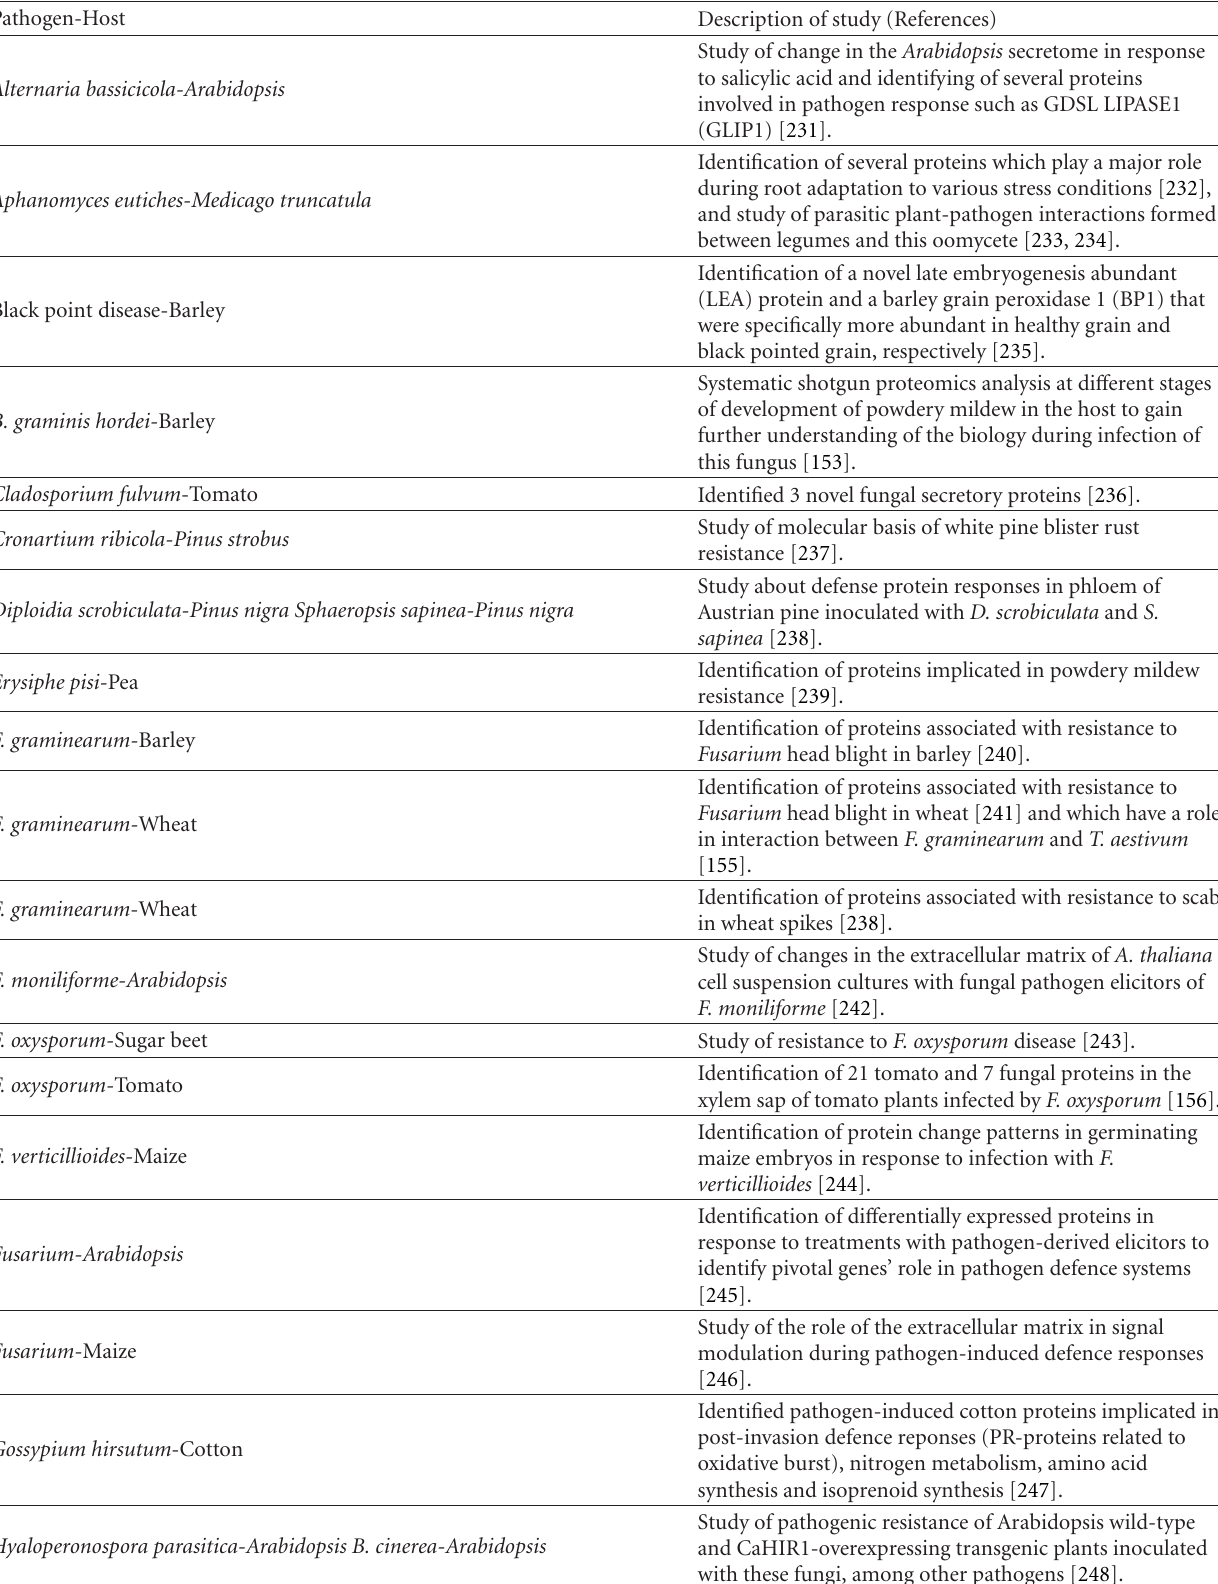
Table 6: Original proteomics papers published in plant-pathogenic fungi